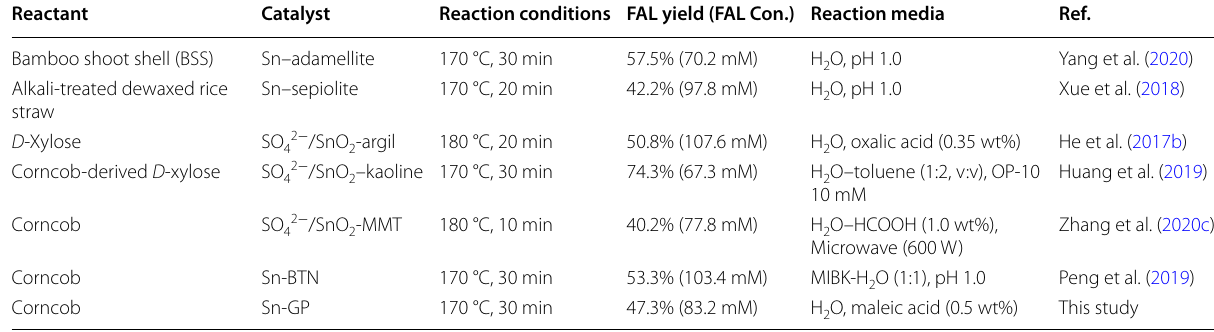
Table 1 Synthesis of furfural from D ‑xylose or biomass by tin‑based solid acids Reactant